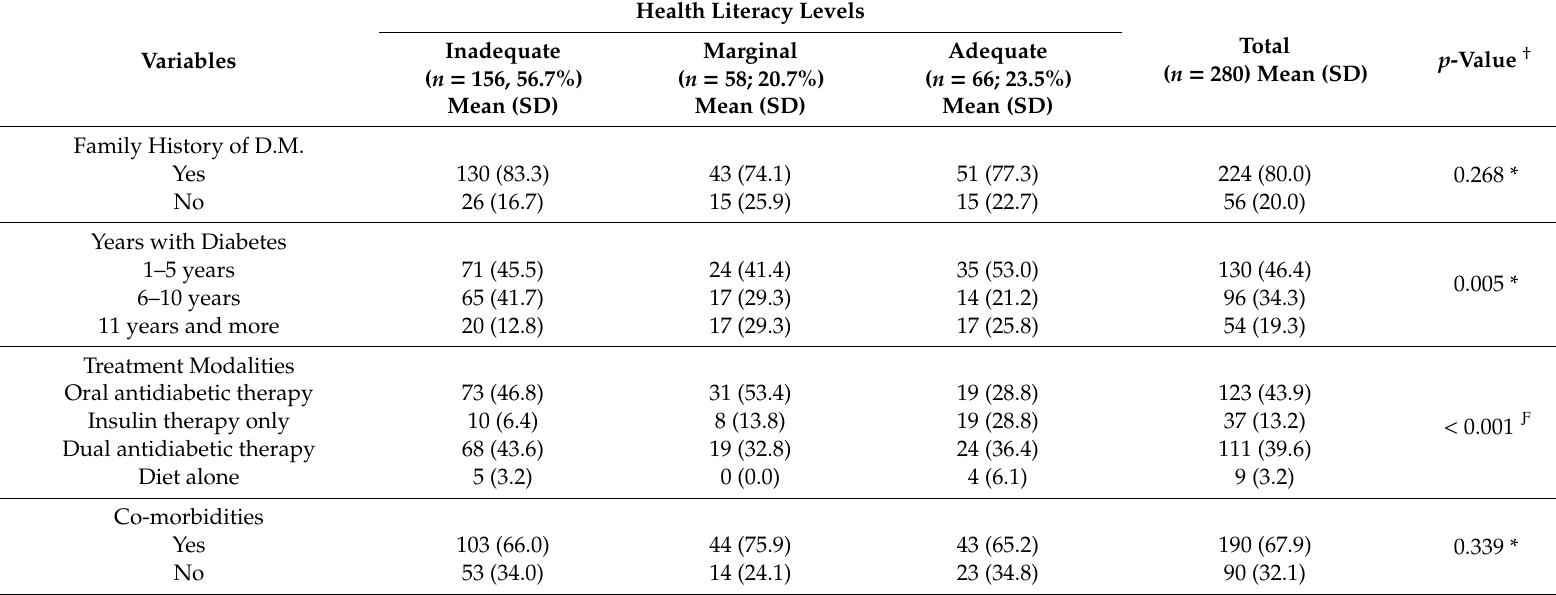
Fisher Exact test was used for categorical variables; ê : scored out of 30; ˆg : scored out of 70; † one-way analysis of variance (ANOVA), for means of continuous variables; N (%). Data are presented as number and percentage, S.D. = standard deviation, US$ = United States Dollar, D.M. = diabetes mellitus. a,b,c = means in a row with di ff